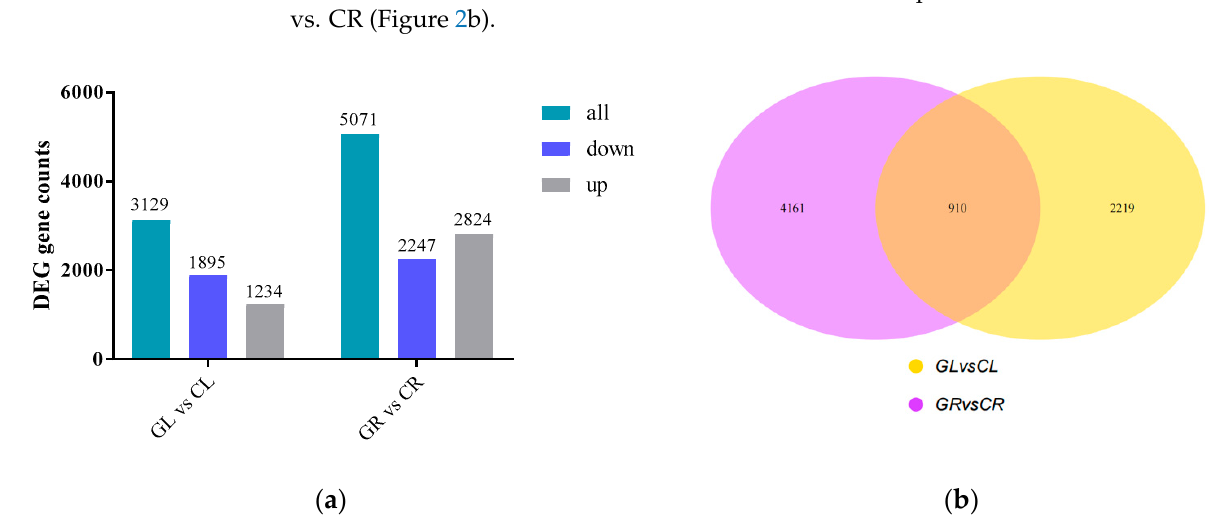
Figure 2. Differentially expressed genes (DEGs) in the shoots (L) and roots (R) of poplars fertilized with Gln (G) or the inorganic N (C). ( a ) The up- and downregulated DEGs by the pairwise comparison of GL vs CL and GR vs CR; ( b ) the Venn analysis of DEGs.